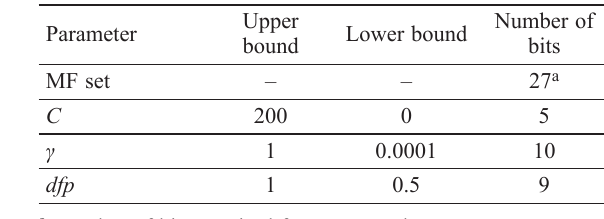
Table 1. Summary of EFSIM parameter settings